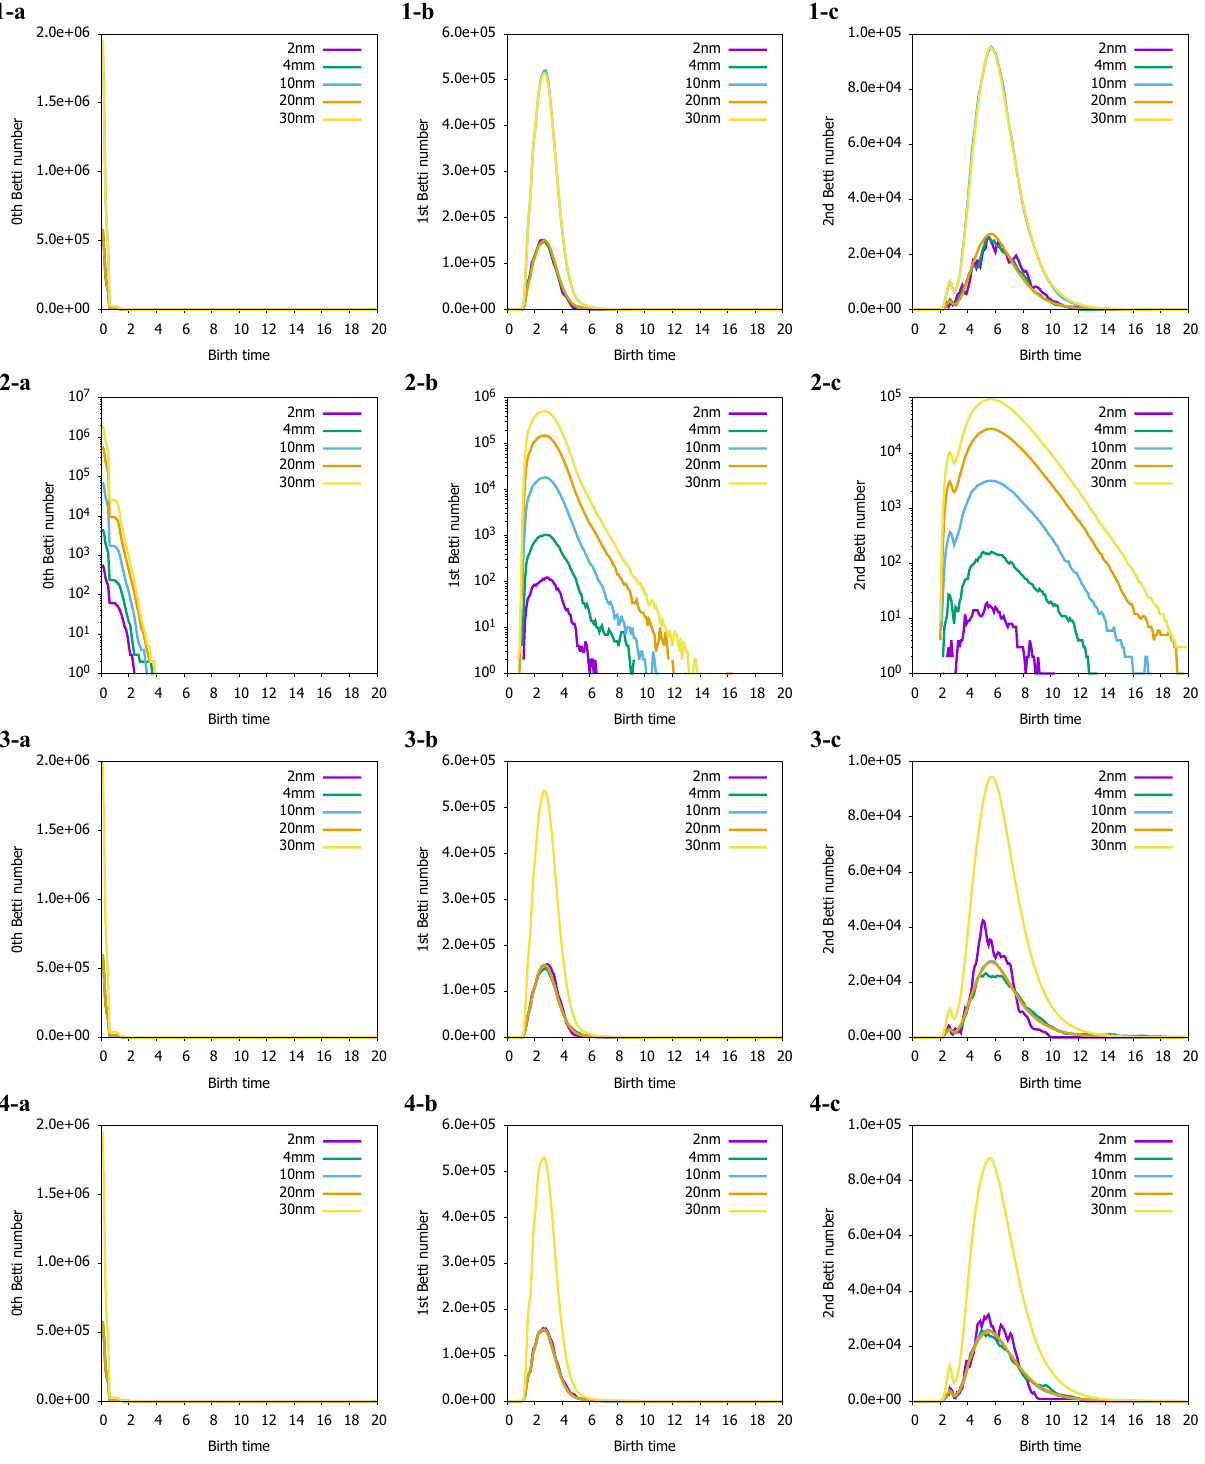
Figure 5. The change in the persistent betti numbers (PBNs) in sample 1. (1) 300 K and 20 mer, (2) 300 K and 20 mer that PD of cellsize 2, 4 and 10 nm without cellsize expanding, (3) 300K and 10 mer, (4) 150 K and 20 mer. (a) 0th PBNs, (b) 1st PBN, (c) 2nd